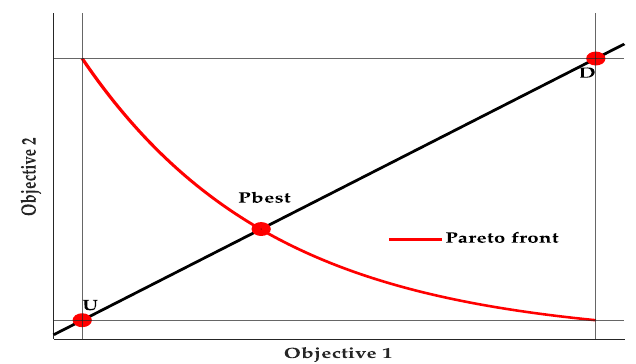
Figure A1. Mathematical interpretation of the KS bargaining solution.